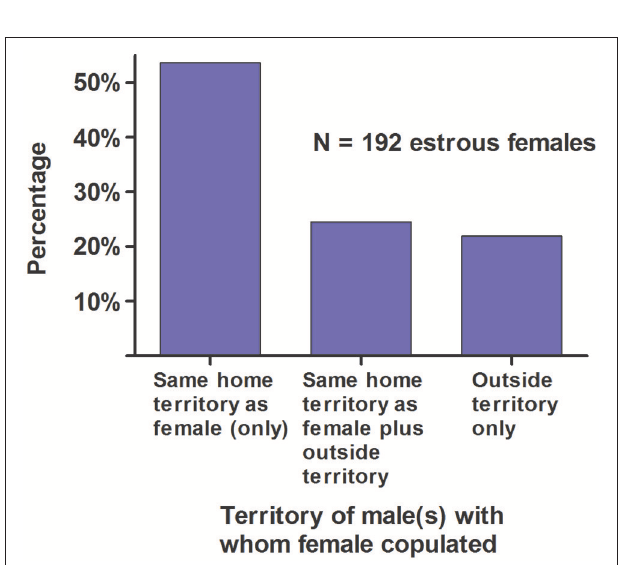
FIGURE 8 | Territory of the male(s) with whom a female copulated for white-tailed prairie dogs at the Arapaho National Wildlife Refuge, Colorado USA, from 2006 through